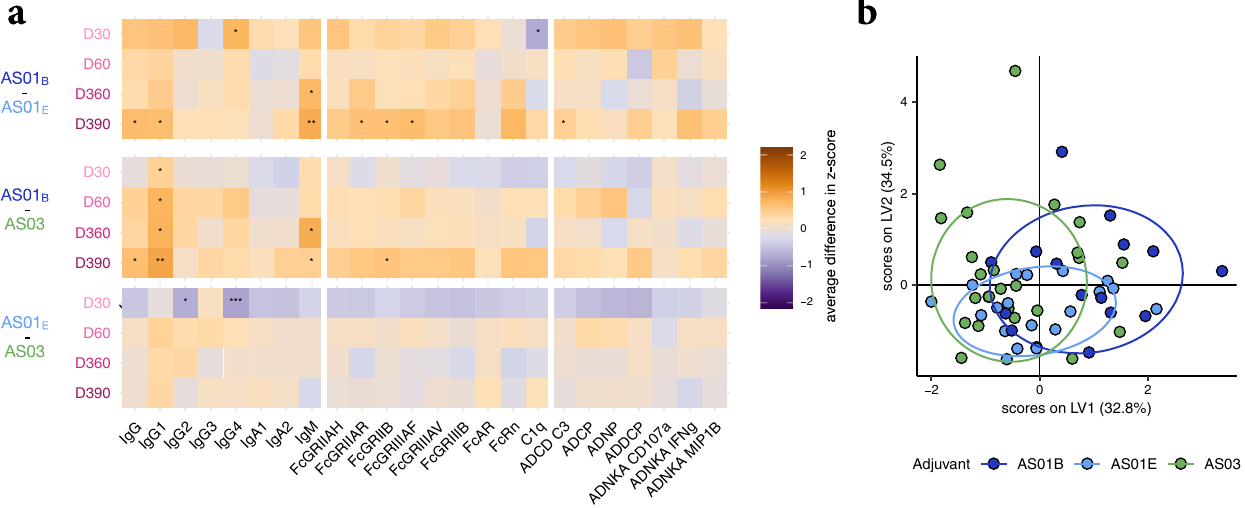
Fig. 4 Similarity in functional antibody responses across AS01 B -, AS01 E -, and AS03- adjuvanted vaccine responses. a The heatmaps depict pairwise differences in antibody features between AS01 B versus AS01 E participant groups (top), AS01 B vs. AS03 participant groups (middle), and AS01 E vs. AS03 participant groups (bottom). Orange tiles indicate that the feature is higher in the fi rst adjuvant group, while purple tiles show enrichment in the second adjuvant group. Signi fi cances were assessed using Mann – Whitney U tests, and asterisks indicate uncorrected P values with * P < 0.05, ** P < 0.01, *** P < 0.001. b A PLS-DA model was built based on LASSO-selected features. The score plot shows high overlap between the high-response adjuvants AS01 B , AS01 E , and AS03, with the strongest overlap between AS01 E and AS03. The model only achieved a balanced accuracy of 0.23 and was not able to discriminate the